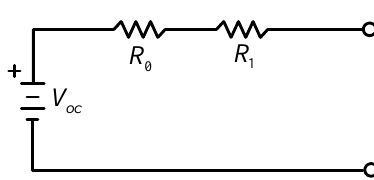
Figure 2. Simplified battery quasi-static circuitry.